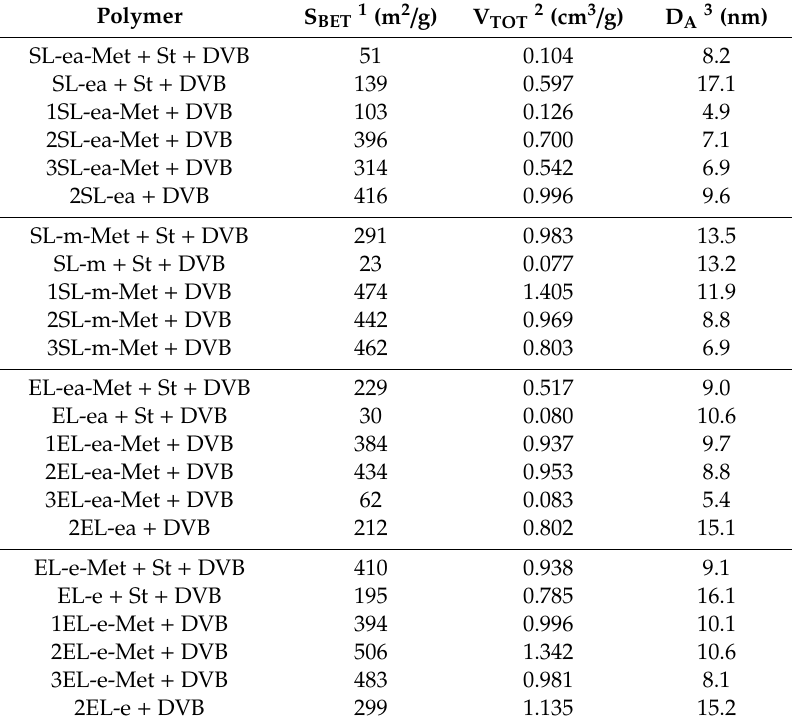
Table 4. Pore structure parameters of the